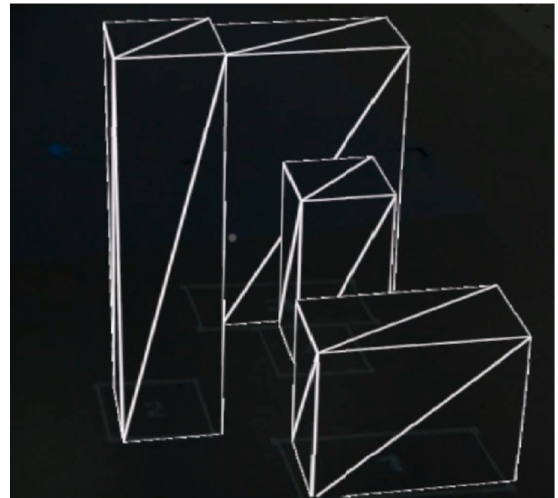
Figure 10. Four wireframe prisms as viewed from the HMD.